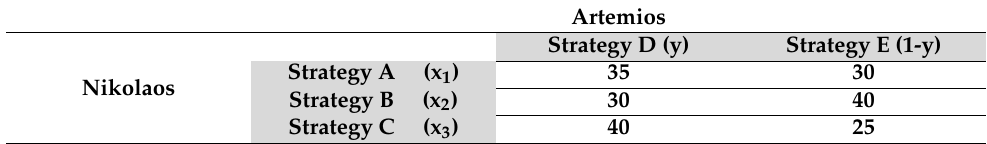
Table 1. Payoffs of Nikolaos under alternative